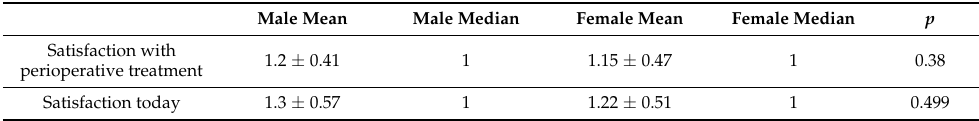
Table 8. Mean and median of treatment satisfaction for both